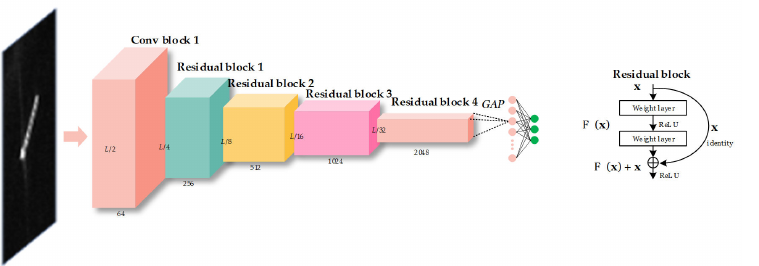
Figure 8. Network architecture of ResNet. ReLU denotes the rectified linear unit activation function, which will be defined by Equation (20).